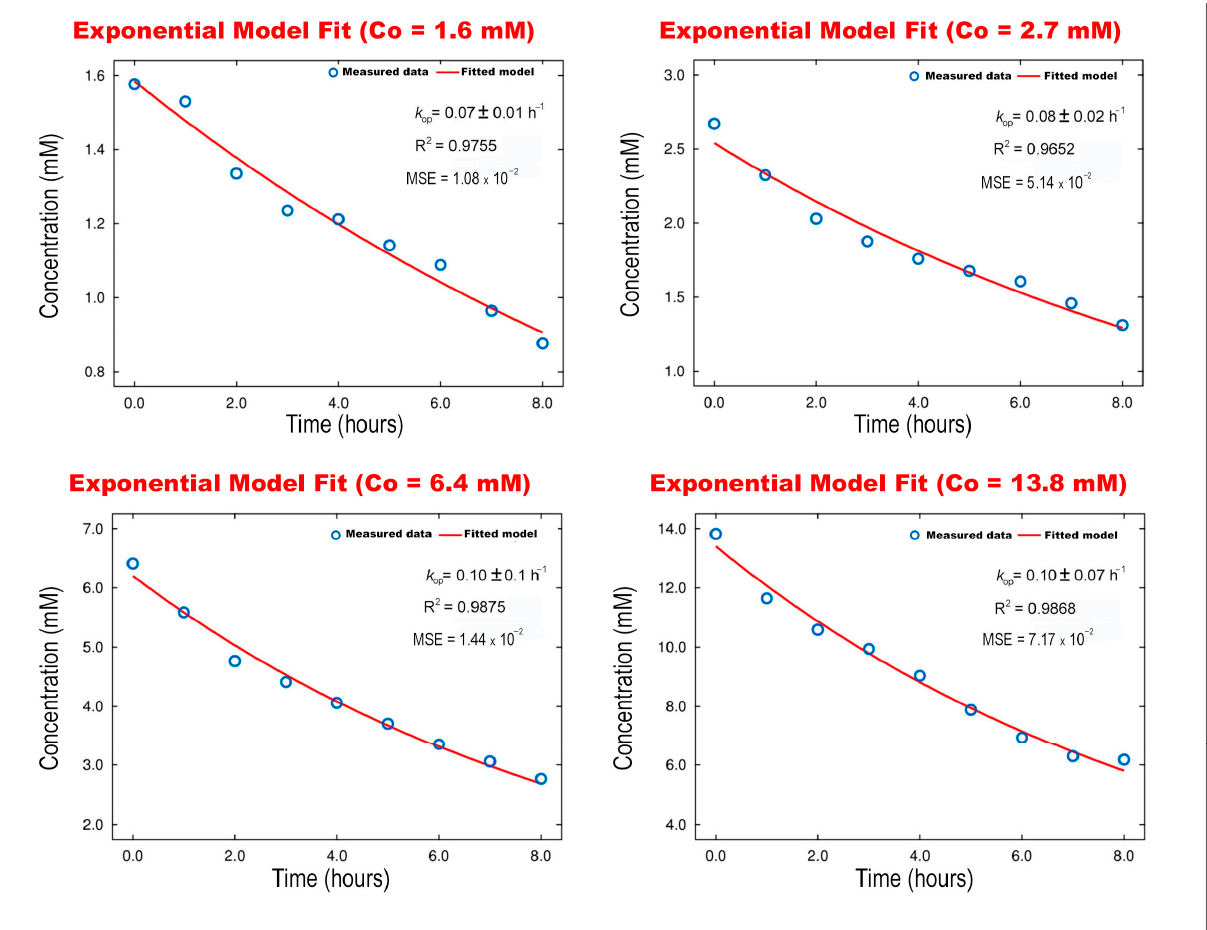
Figure 10. Fit to the monoexponential rate equation tending to zero baseline of the experimental points C t ( t ) of the ammonia removal photocatalytic process at different initial ammonia concentra- tions (pH = 11.0, P = 25 W, Q = 1000 L/h, temperature = 20 ± 1 ◦ C).